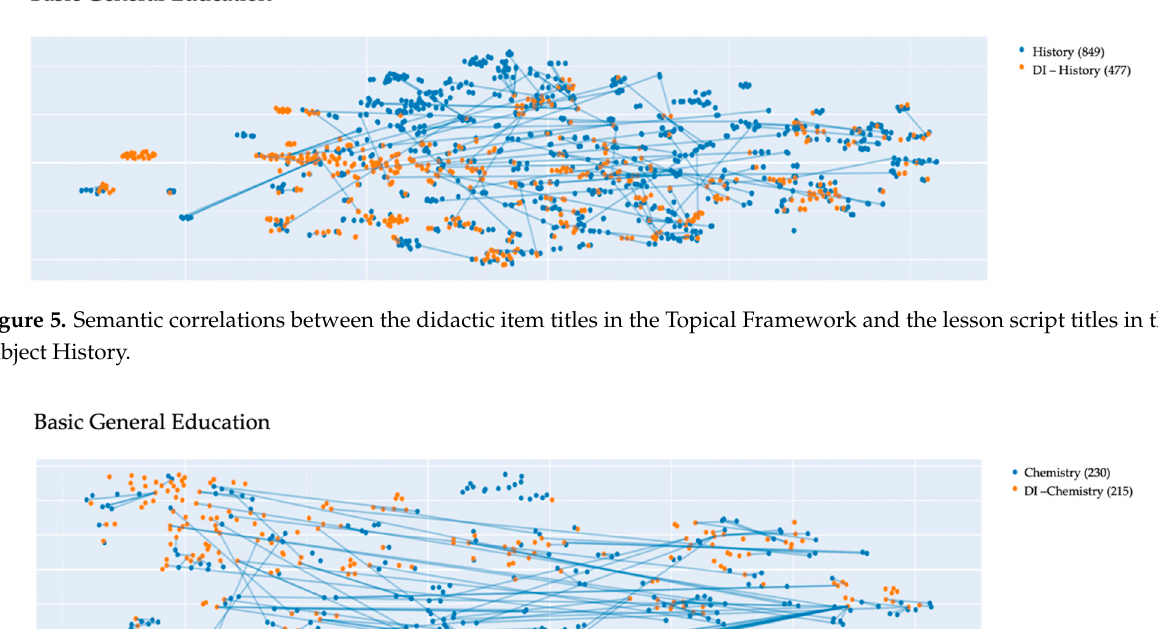
Figure 4. Semantic correlations between the didactic item titles in the topical framework and the lesson script titles in the subject French language.